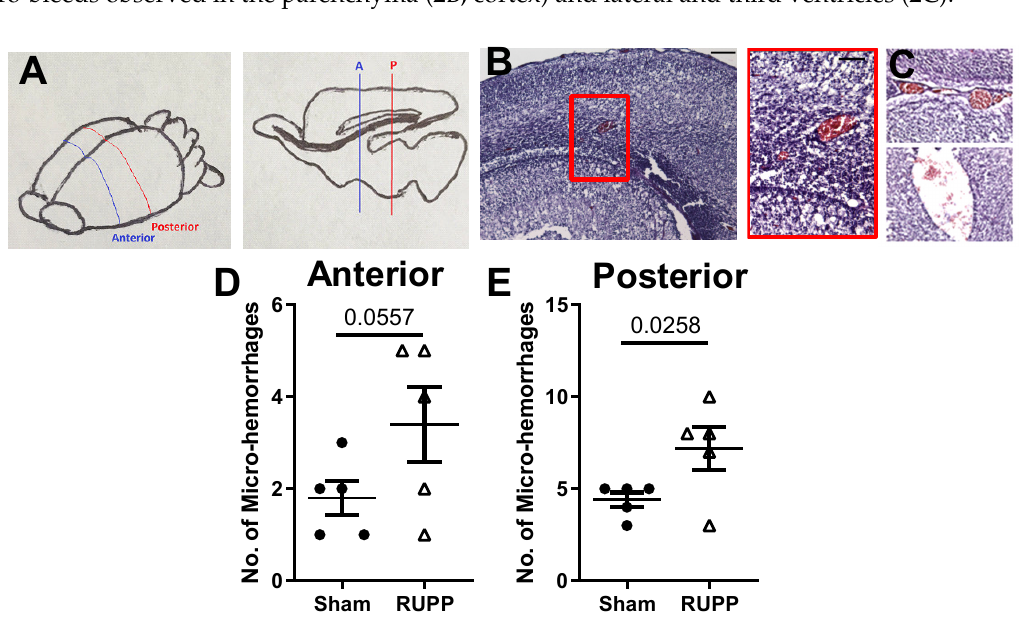
Figure 2. Placental ischemia exposure leads to increased number of micro-bleeds in brains of exposed fetuses. ( A ) Schematic of the regions where coronal sections were collected. ( B ) Representative images of fetal brains showing micro-bleeds in the cortex and ( C ) ventricles. Number of micro-bleeds in the ( D ) anterior ( E ) posterior slices of fetal brains. Points represent average micro-bleeds from 1–2 pups per dam (n = 5 dams per group). Mean ± SEM is also depicted. Data were analyzed using unpaired t -test and p -values are indicated.